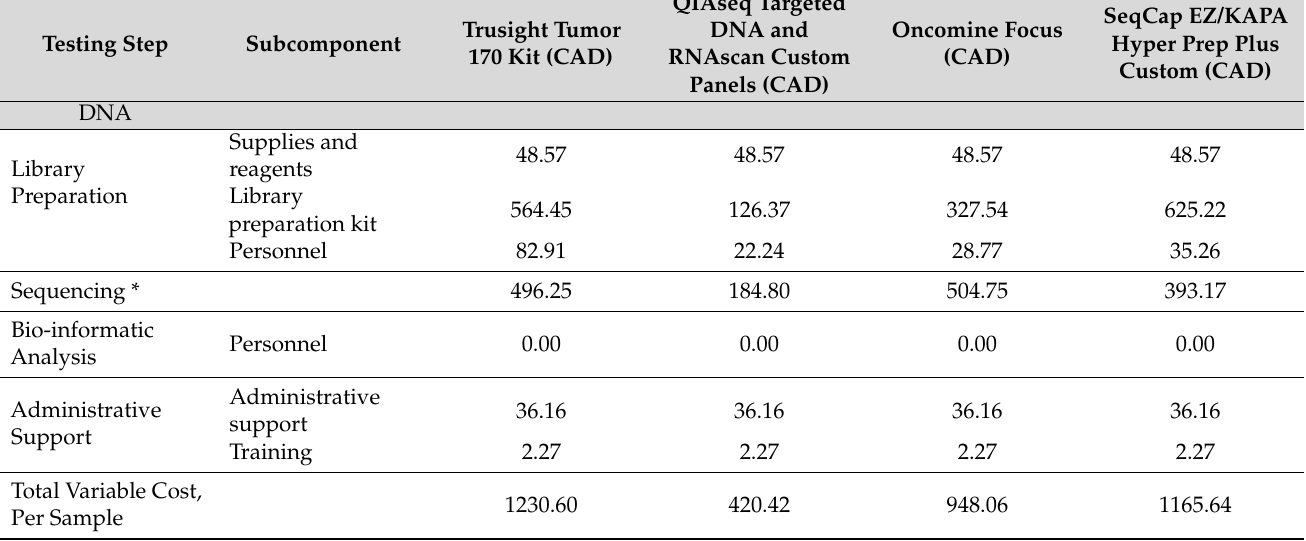
Table 3. Variable costs per sample, by